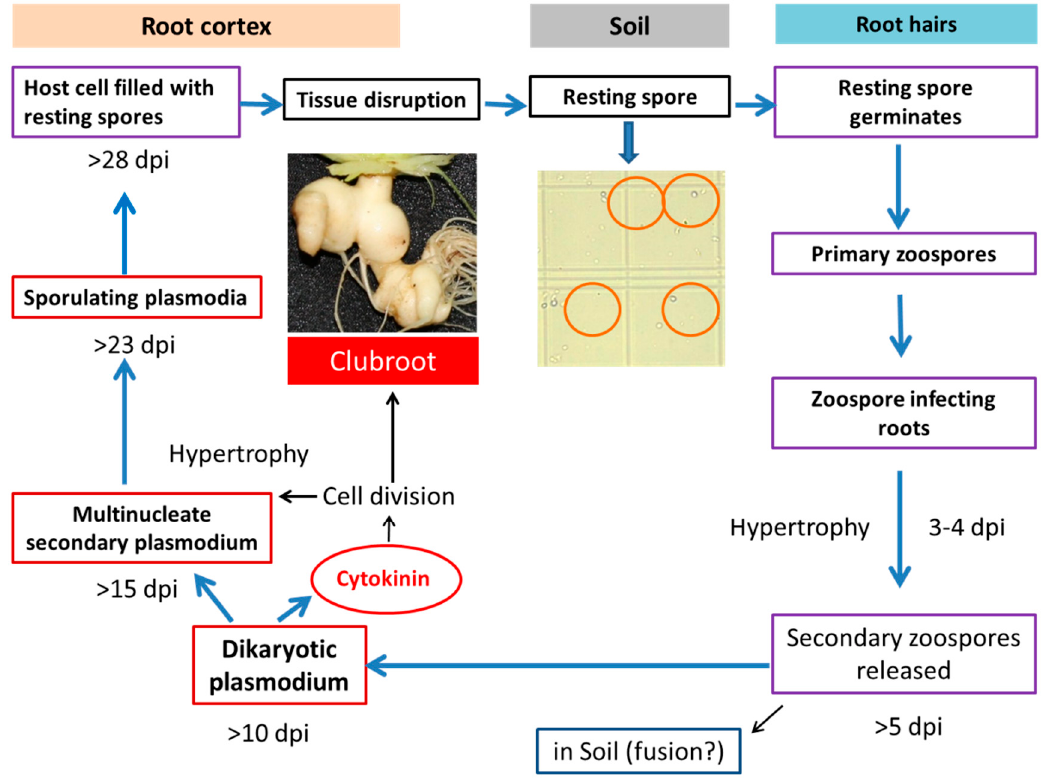
Figure 1. Involvement of cytokinin in clubroot formation during the life cycle of Plasmodiophora brassicae (Robin et al. [13] after Dekhuijzen [14], Müller and Hilgenberg [15]). dpi, days post inoculation.